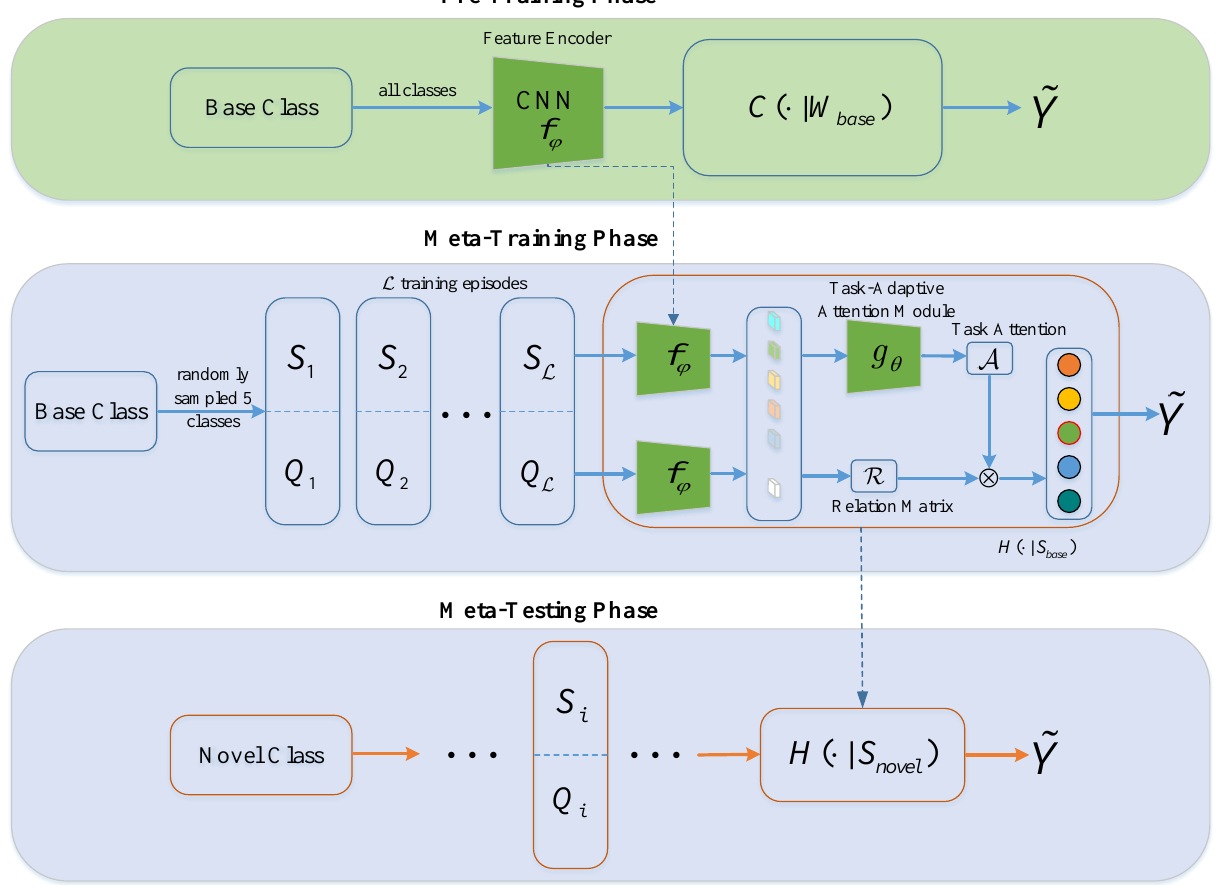
Figure 2. The overall architecture and details of the task-adaptive embedding network (shortened to